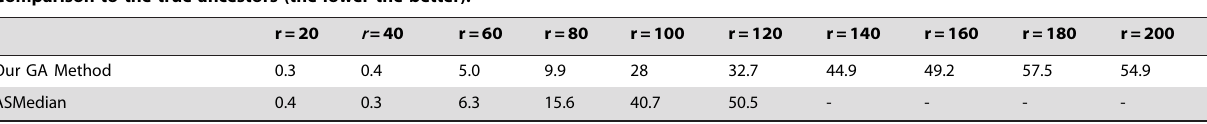
Comparison to the true ancestors (the lower the better):